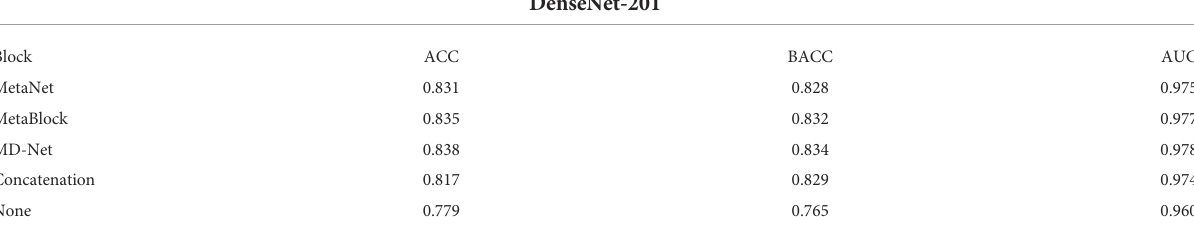
TABLE 11 Compare the performance of DenseNet-201 network fusing different modules on the ISIC 2019 dataset. HIGHEST AVERAGE BACC FOR EACH